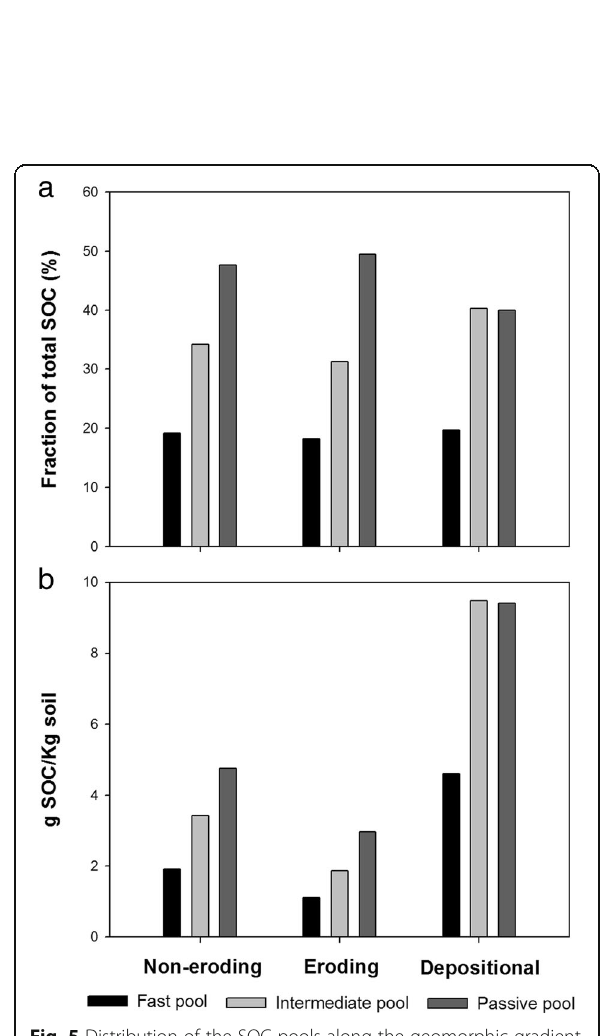
Fig. 5 Distribution of the SOC pools along the geomorphic gradient as a fraction of the total SOC in % ( a ) and the absolute amount in g SOC per kg soil ( b